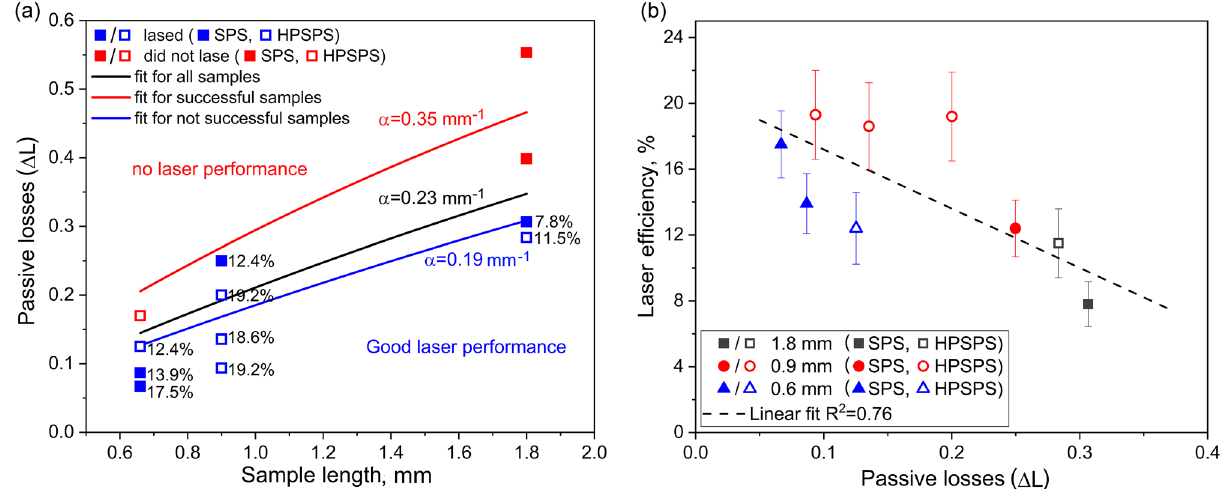
Figure 6. ( a ) Passive losses as a function of ceramics length. Lasing efficiencies are noted for each sample. Blue and red represent samples that lased and sample that did not laser, respectively. ( b ) Slope efficiency as a function of passive losses for samples which lased. Different colors account for different sample lengths. Full and hollow notations represent SPS- and HPSPS-processed samples,